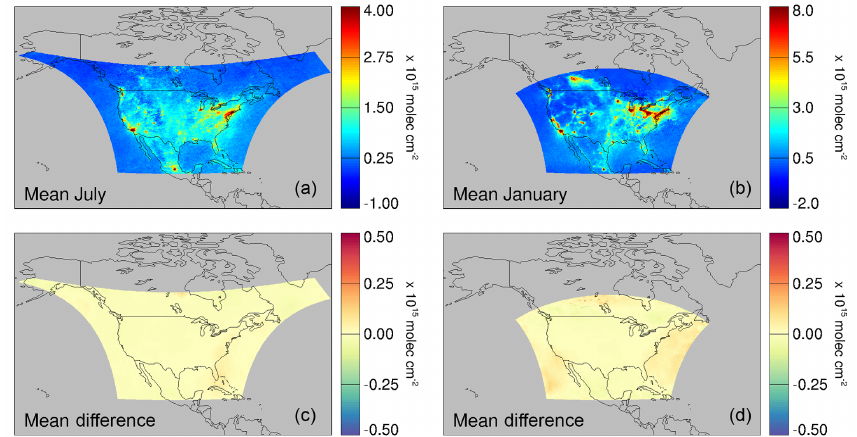
Figure 8. Panels (a, b) show mean July and January tropospheric NO 2 column densities resulting from our TEMPO algorithm. Panels (c, d) show absolute difference in mean July and January tropospheric NO 2 between the TEMPO algorithm and the global